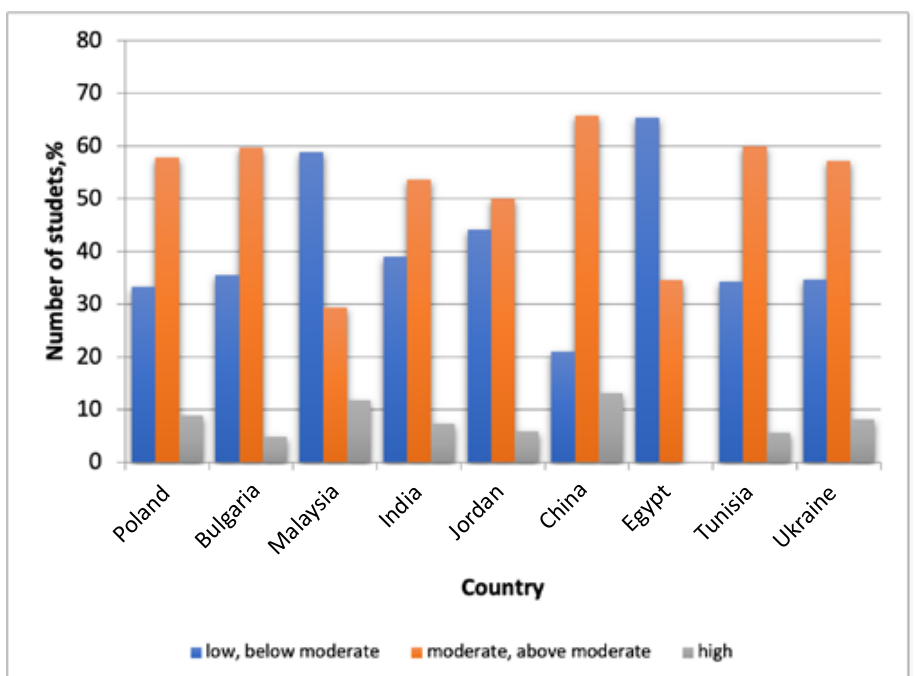
Figure 4. Distribution of students by handgrip strength index level